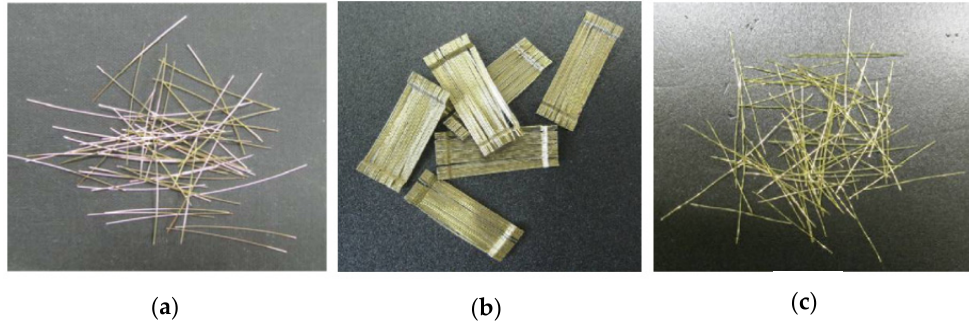
Figure 4. Types of steel fibres: ( a ) smooth macro-fibre, ( b ) hooked macro-fibre and ( c ) twisted macro-fibre ([42]–Elsevier Copyright).